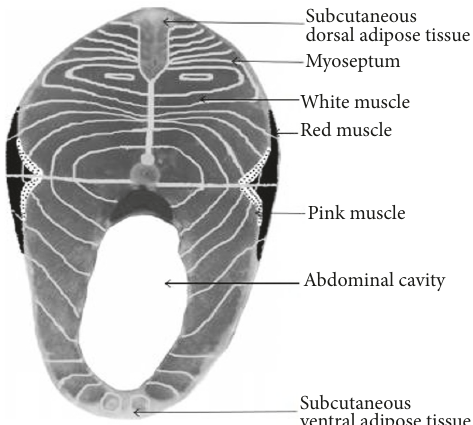
Figure 4: Organization and distribution of muscle mass on a trout cutlet (Figure 4 is reproduced from [21] [under the Creative Commons Attribution License/public